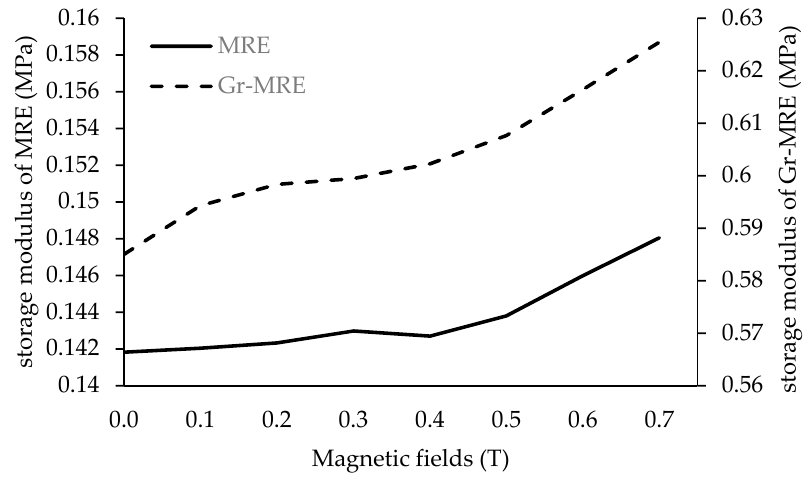
Figure 9. The MR effect of MRE and Gr-MRE samples at magnetic fields of 0–0.7 T.